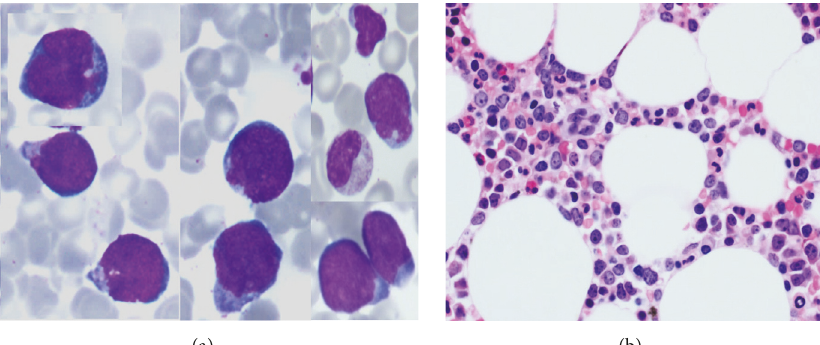
Figure 3: BM aspirate smear shows numerous abnormal medium to large-sized lymphoid cells. The cells showed slightly irregular nuclear contours, dispersed nuclear chromatin, and basophilic cytoplasm (Wright stain, 1,000x) (a). BMB biopsy (H&E 50x): interstitial infiltration with malignant lymphoid cells (b).